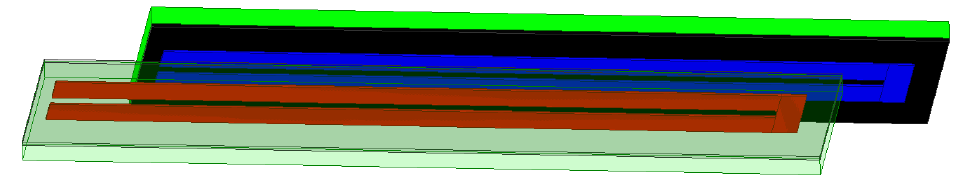
Figure 6. Simplified simulation model of inductosyn.